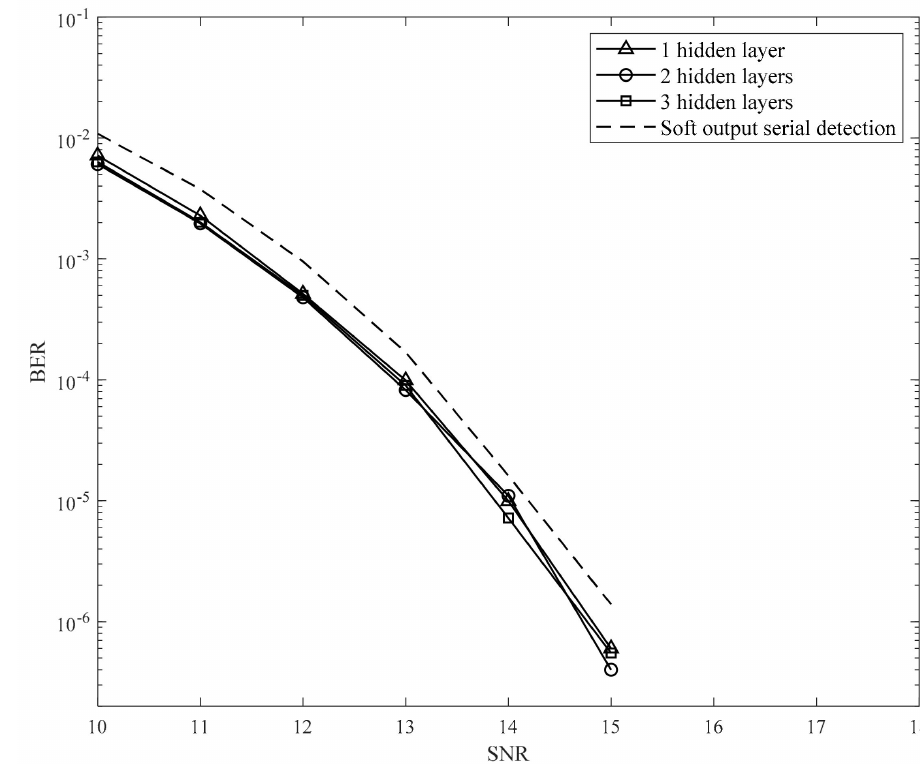
Figure 18. The BER performance of the third model with 10%